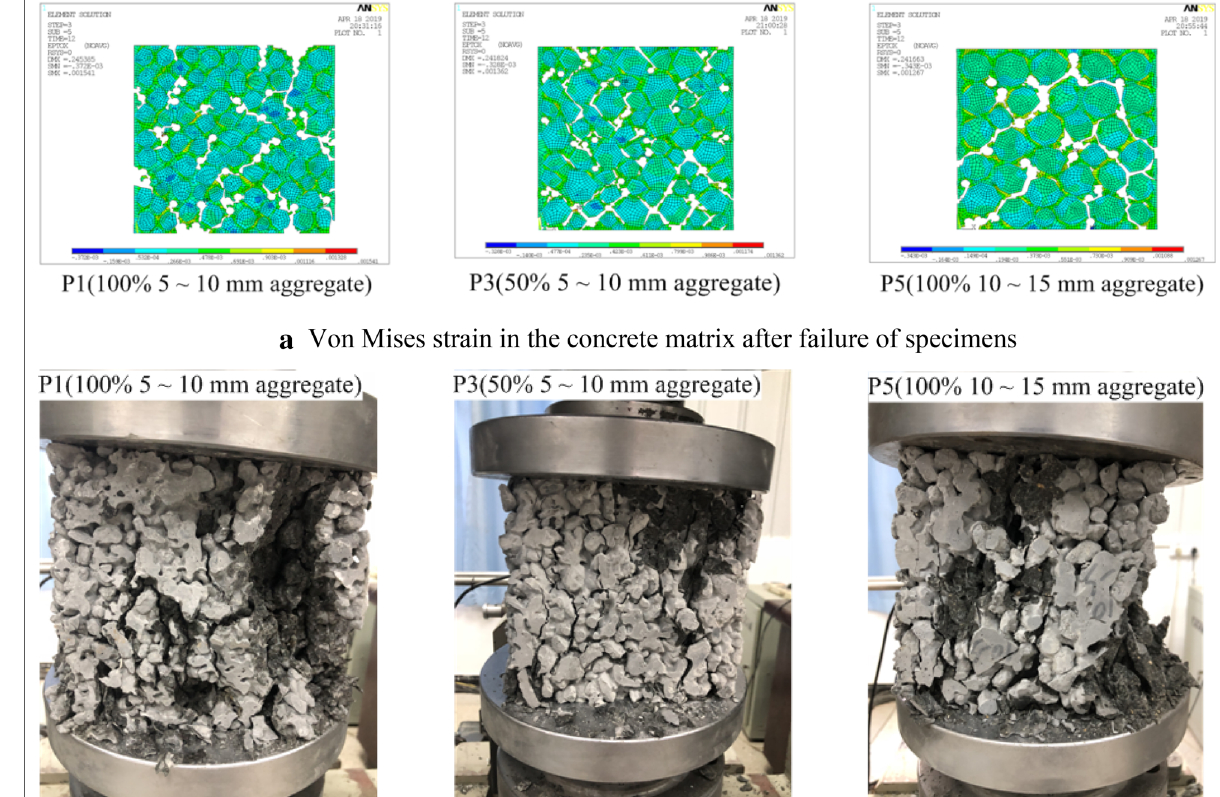
Fig. 11 Failure patterns in the a numerical result and b the corresponding laboratory